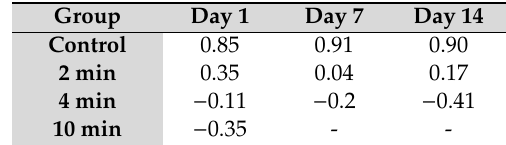
Table 4. Decorrelation between cells’ and nuclei distributions. Quantitative analysis of karyoplasmic (nuclei / cell) ratios. Correlation coe ffi cients calculated by Pearson’s formula for cells and nuclei distributions. Two-minute irradiation reduced the nuclei size slightly as compared to cellular size, while 4 min irradiation increased the nuclei size. The observations indicate di ff erent durations of exposure e ff ects cell morphology di ff erently. The control groups show strong positive correlation while the irradiated groups reveal strong decorrelation (weak positive for 2 min exposure and strong negative for 4 and 10 min exposure). Cells under 10 min exposure died before reaching Day 7 and 14 of the observation period following MMW treatment. Indicated values represent the mean of three independent experiments. Group Day 1 Day 7 Day 14 Control 0.85 0.91 0.90 2 min 0.35 0.04 0.17 4 min − 0.11 − 0.2 − 0.41 10 min − 0.35 -